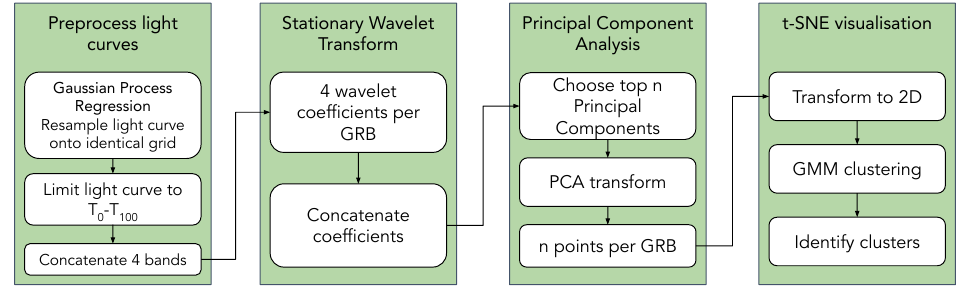
Figure 1. Flowchart of the feature extraction and clustering algorithm for analysis of 64 ms-binned light curves in the interval T 0 to T 100 .